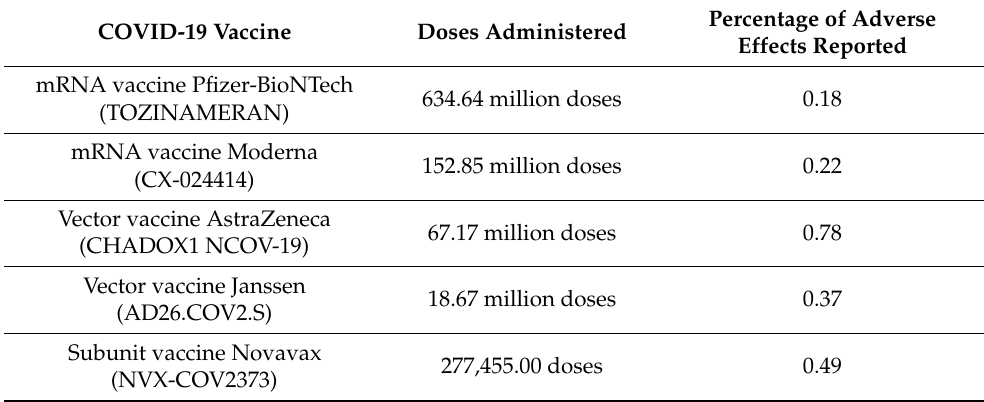
Table 2. COVID-19 vaccines included in the EudraVigilance database, doses administered in EU, and the percentage of adverse effects reported, until 17 September 2022 [42,43].